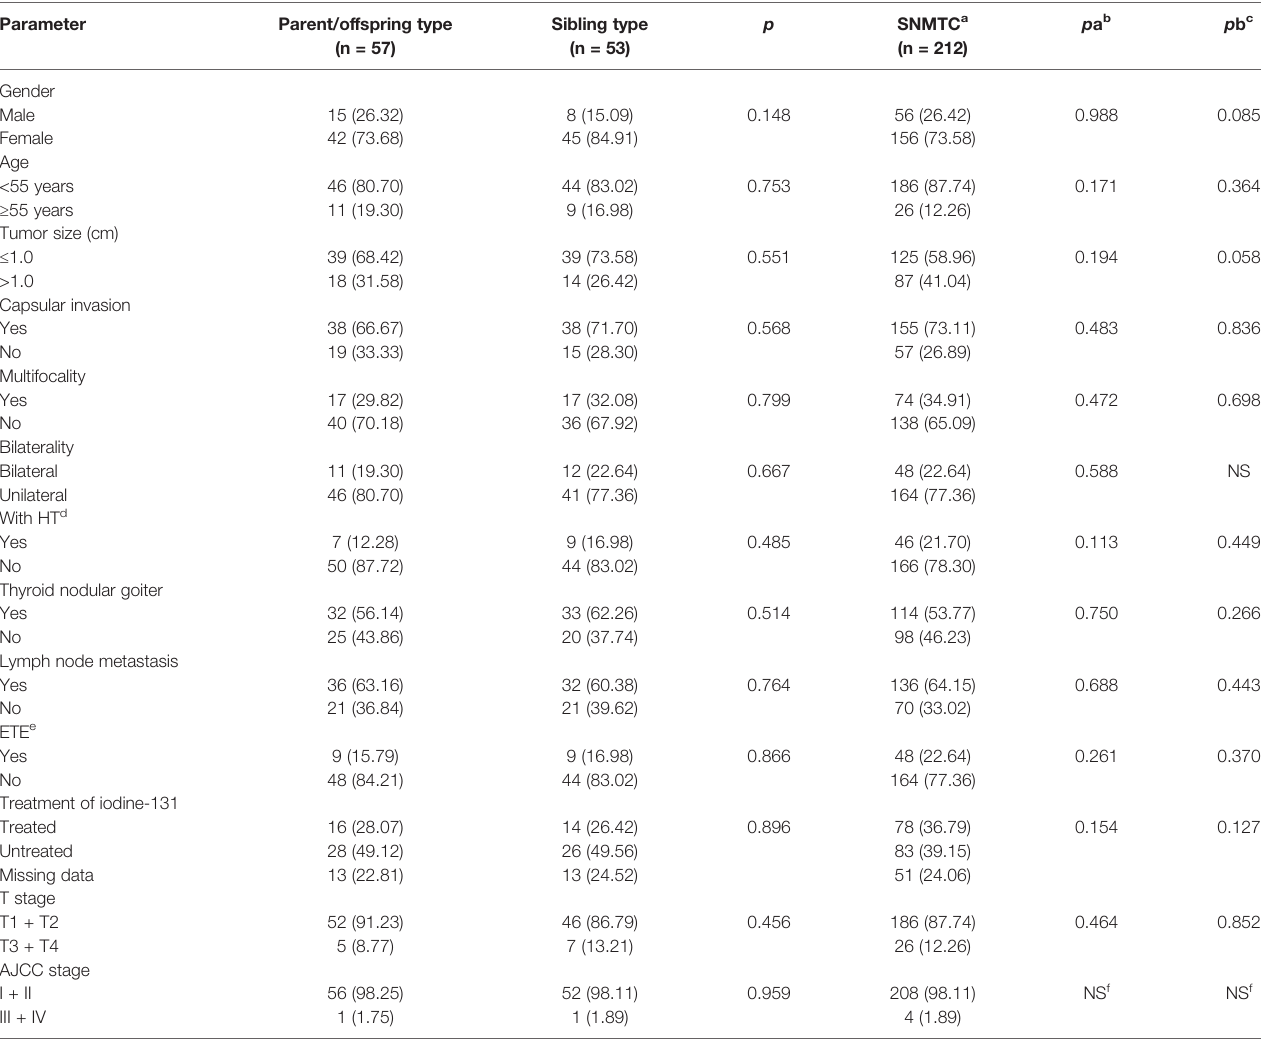
TABLE 4 | Clinicopathological characteristics and prognostic factors of t parent/offspring type group and sibling type group vs. SNMTC, n (%).